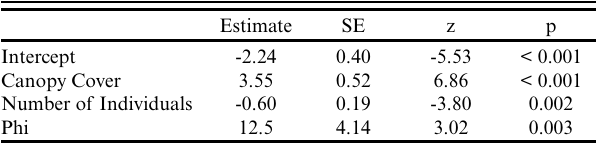
Table 1 . Results from beta regression analysis, where response variable is the proportion of total Ovenbird ( Seiurus aurocapilla ) singing locations on the